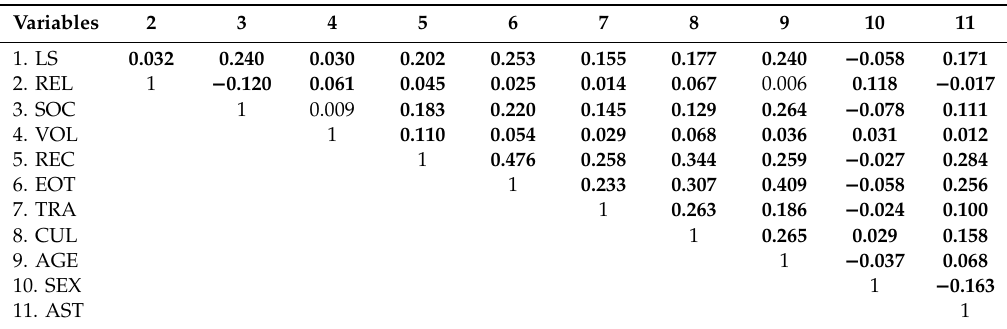
Table 2. Correlation